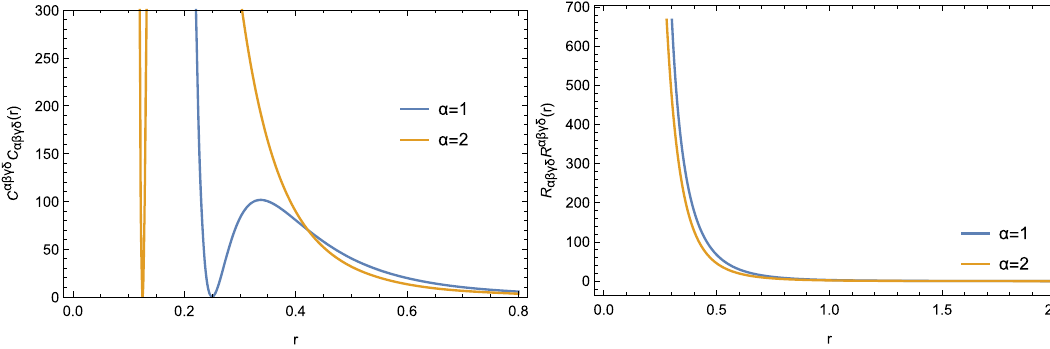
Fig. 3 The norm of the Weyl tensor (left) and the Kretschmann scalar (right) as functions of r for different values of the parameter